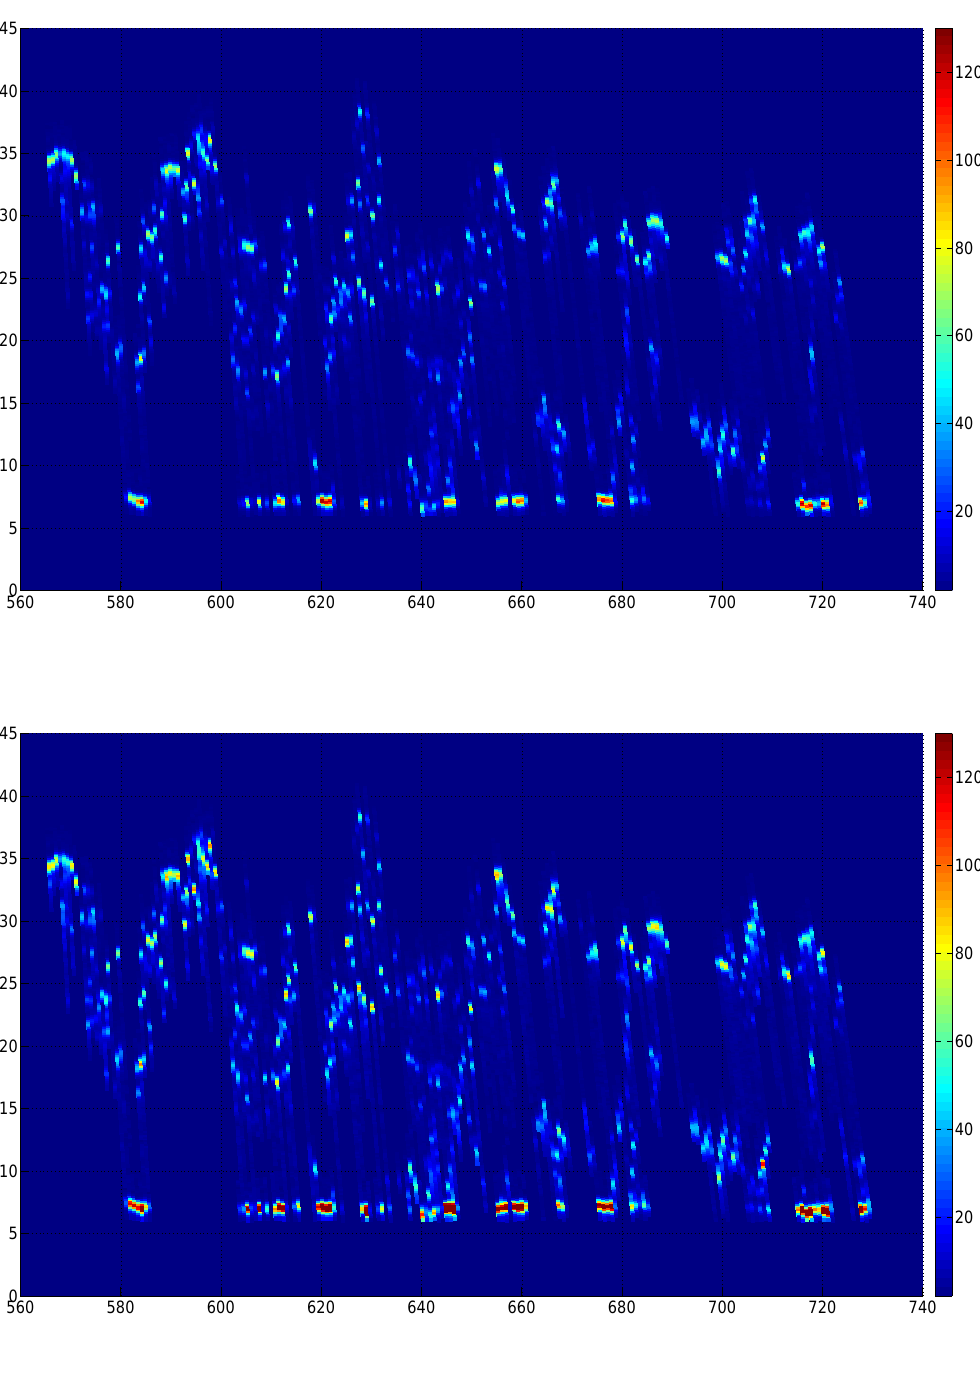
Figure 7: Vertical view of one scan line with color coded waveforms, top: raw data, bottom: corrected data (reference value: maximum integral of all eligible reference